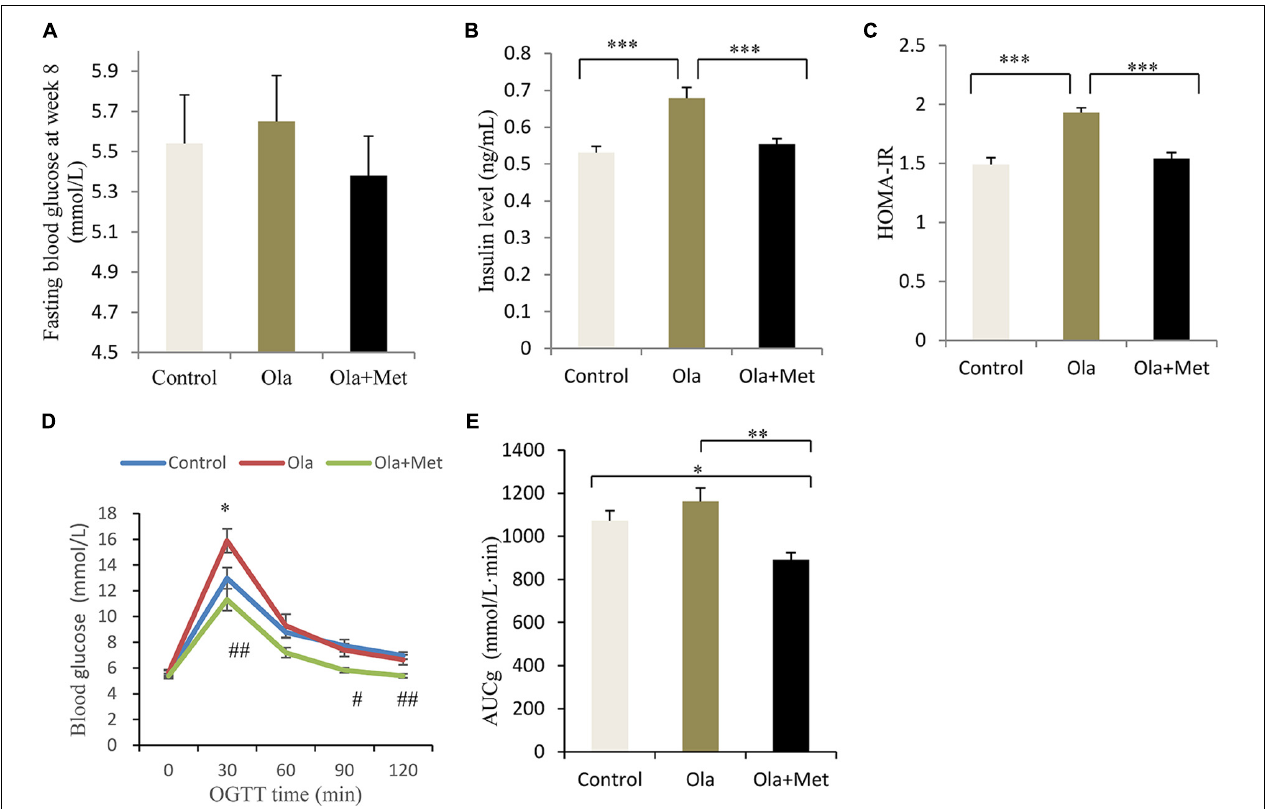
FIGURE 2 | Comparison of the fasting glucose, insulin level, insulin resistance, and glucose tolerance between different treatment groups in C57BL/6 mice. C57BL/6 mice were treated with olanzapine (4 mg/kg/day, Ola), olanzapine (4 mg/kg/day, Ola) + metformin (150 mg/kg/day, Met), or saline for 8 weeks. Effect of different treatment groups on fasting glucose (A) , insulin level (B) , and HOMA-IR (C) at the end of 8-week treatment. (D) Oral glucose tolerance test (OGTT) on overnight fasted mice from olanzapine group, olanzapine + metformin group, and control group after 8 weeks of treatment. Blood glucose level was measured before and 30, 60, 90, and 120 min after glucose administration (2 g/kg body weight). ∗ p < 0.05, Ola vs. Control group; # p < 0.05, ## p < 0.01, Ola +Met vs. Ola group. (E) Area under curve of glucose (AUCg) of three treatment groups determined by OGTT. AUCg was calculated following trapezoidal rule from 0 to 120 min. Values ( n = 10 for each group) were reported as mean ± SEM. ∗ p < 0.05, ∗∗ p < 0.01, and ∗∗∗ p <